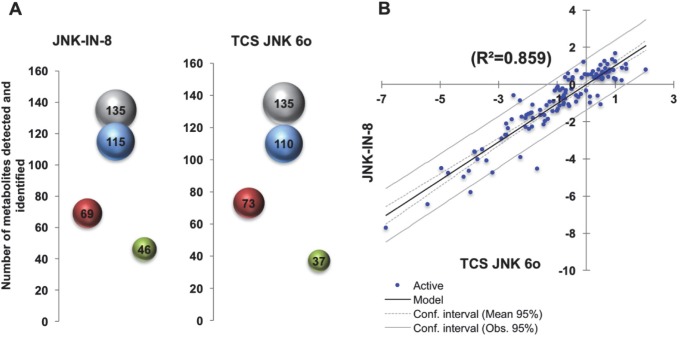
Midgut metabolites identified in A. stephensi treated with JNK SMIs.(A) 3-D bubble plot of the number of midgut metabolites detected in this study by GC-MS/MS. In grey, number of metabolites detected and identified; blue, number of metabolites with a different abundance than controls (LOG2 ratio >0.3 and <-0.3); in red, number of metabolites with higher concentrations than controls; green, number of metabolites with concentrations lower than controls. Bubble area is proportional to the number of metabolites (indicated at the center of each bubble). (B) Linear regression of the LOG2 ratios of metabolites associated with JNK-IN-8 and TCS JNK 6o treatments. A total of 81% of metabolites identified in both treatments showed an overlap (only 11.5% were unique to JNK-IN-8 and 7.3% to TCS JNK 6o). Both treatments resulted in similar metabolomes with relatively similar concentrations as judged by regression (r2 = 0.859; p < 0.001 Pearson’s; XLSAT).